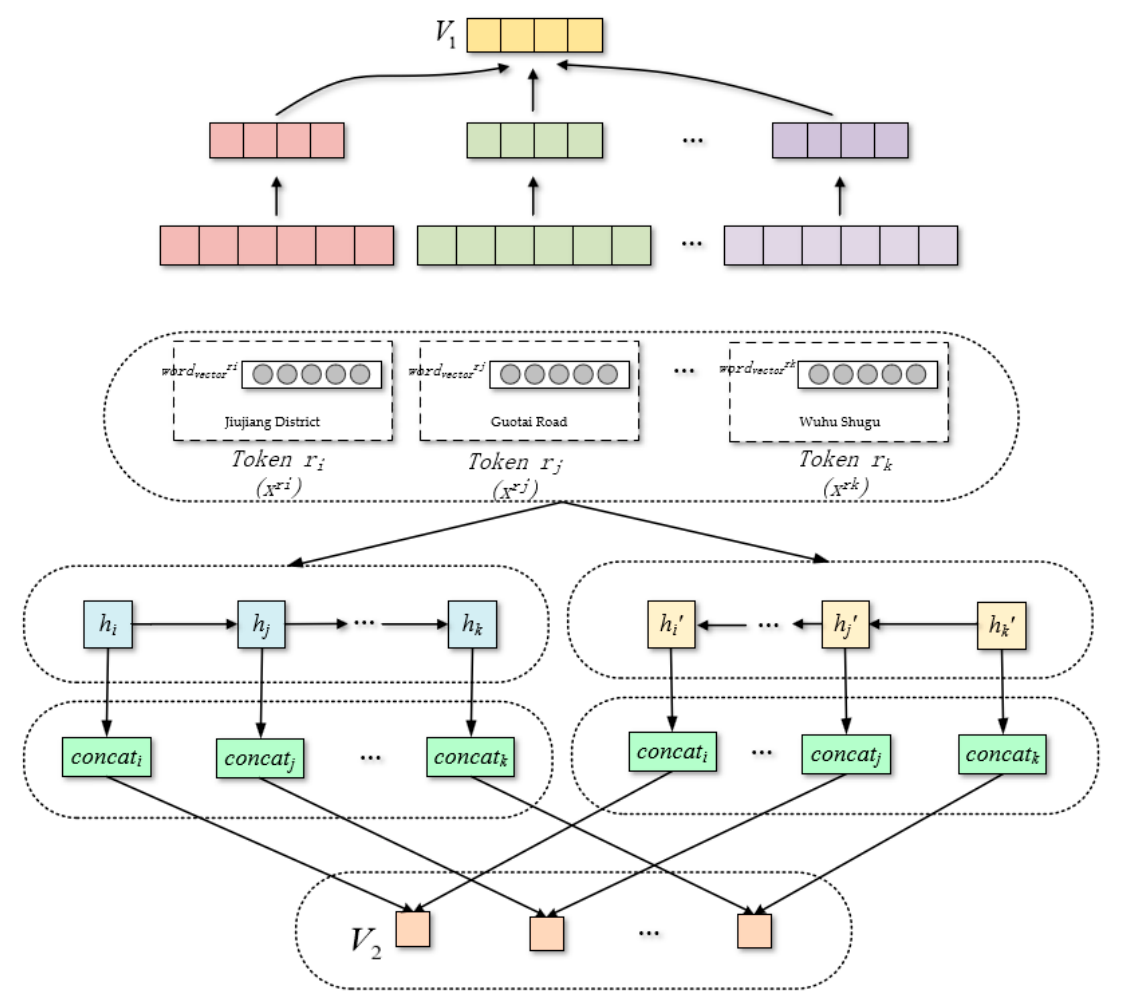
Figure 3. The Structure of Bi-LSTM module.